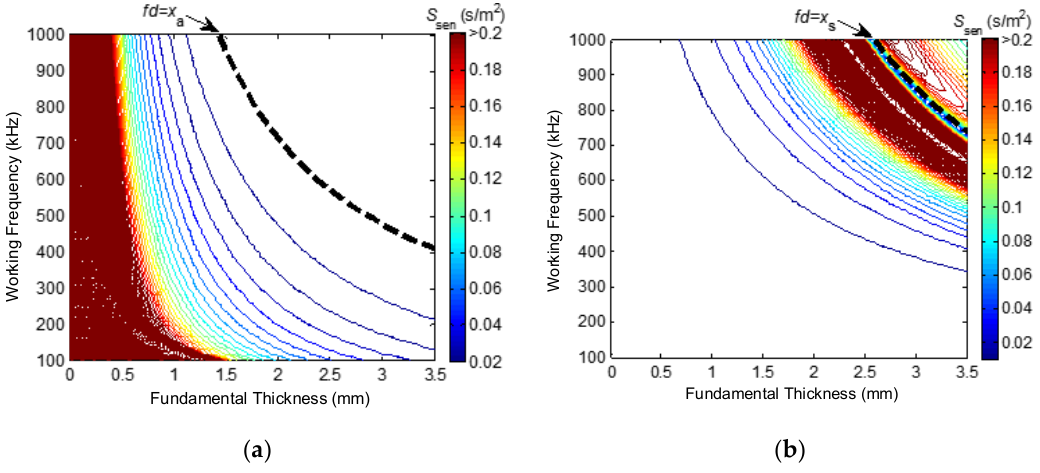
Figure 2. Two-dimensional distribution of sensitivity S sen ( f , d ) on the frequency–thickness plane. ( a ) A0-mode LW and ( b ) S0-mode LW.